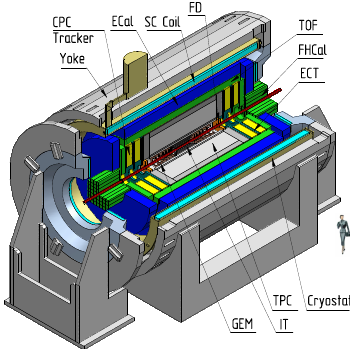
Figure 1. Three-dimensional view of the MPD